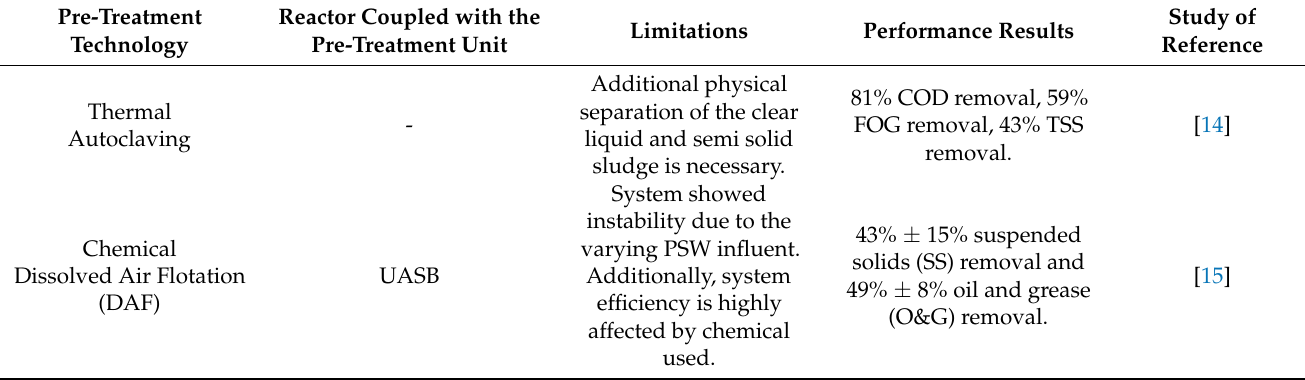
Table 2. Developed pre-treatment technologies and their COD, FOG, and TSS removal